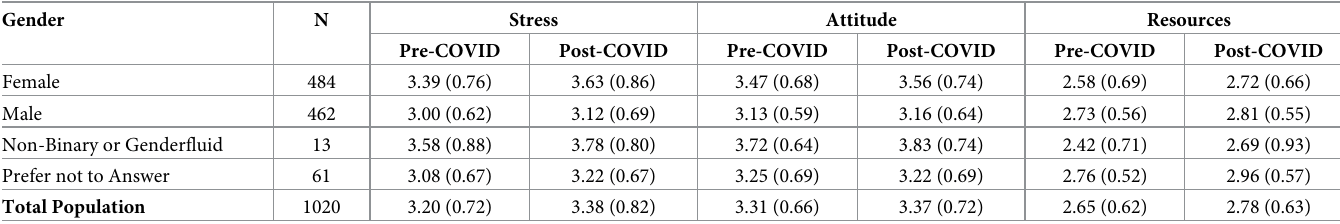
Table 3. Publication pressure questionnaire subscale scores stratified by gender.